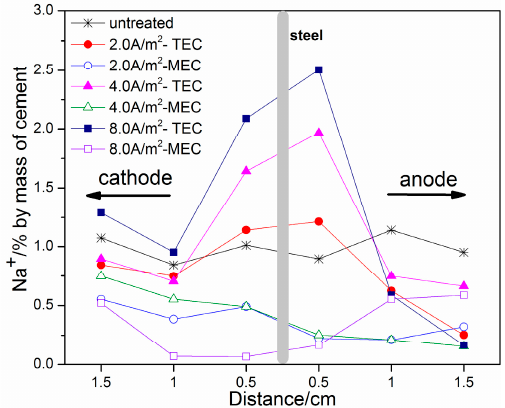
Figure 8. Concentrations of Na + ions as a function of location (untreated, after the TEC treatment and the MEC treatment).